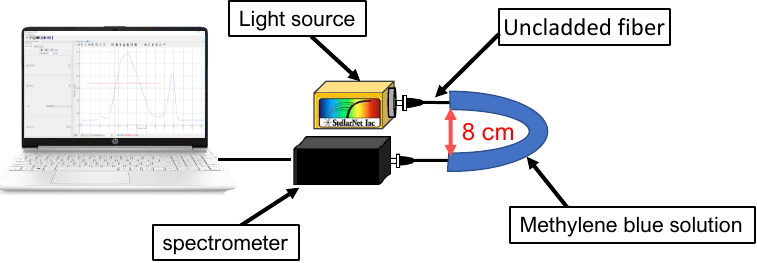
Figure 1. Scheme of the test rig employed for the evaluation of the evanescent wave absorption in the uncladded fibers.